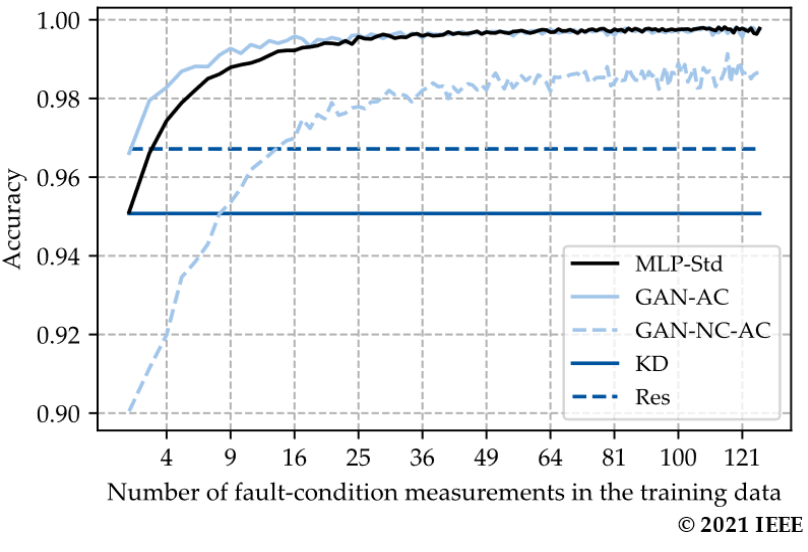
Figure 15. Learning curves of the state-of-the-art diagnostic systems